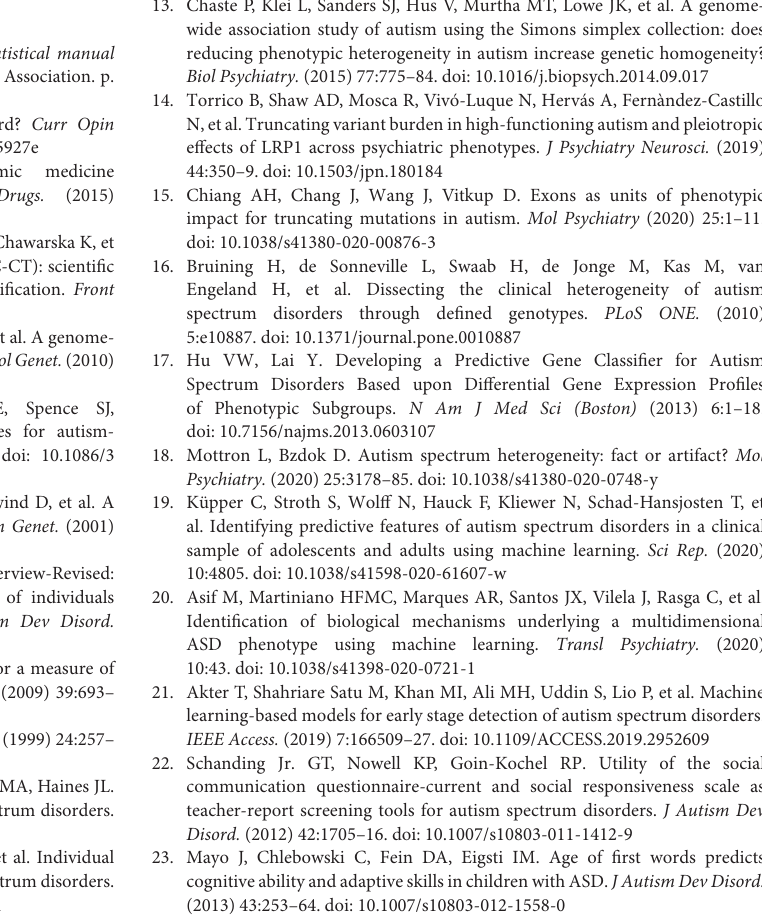
Supplementary Figure 1 | The evaluation of potential batch effect due to the microarrays timing. (A) The kernel density distributions of gene expression levels of the two batches are shown. (B) Time 1 and time 2 indicate the association test results that adjusted for the time (i.e., batch) vs. the results without adjusting for the time. Supplementary Figure 2 | Randomly selected four probes associated with SCQ scores stratified by the presence of language impairment. The red and blue curves represent the group without language impairment and the group with language impairment,